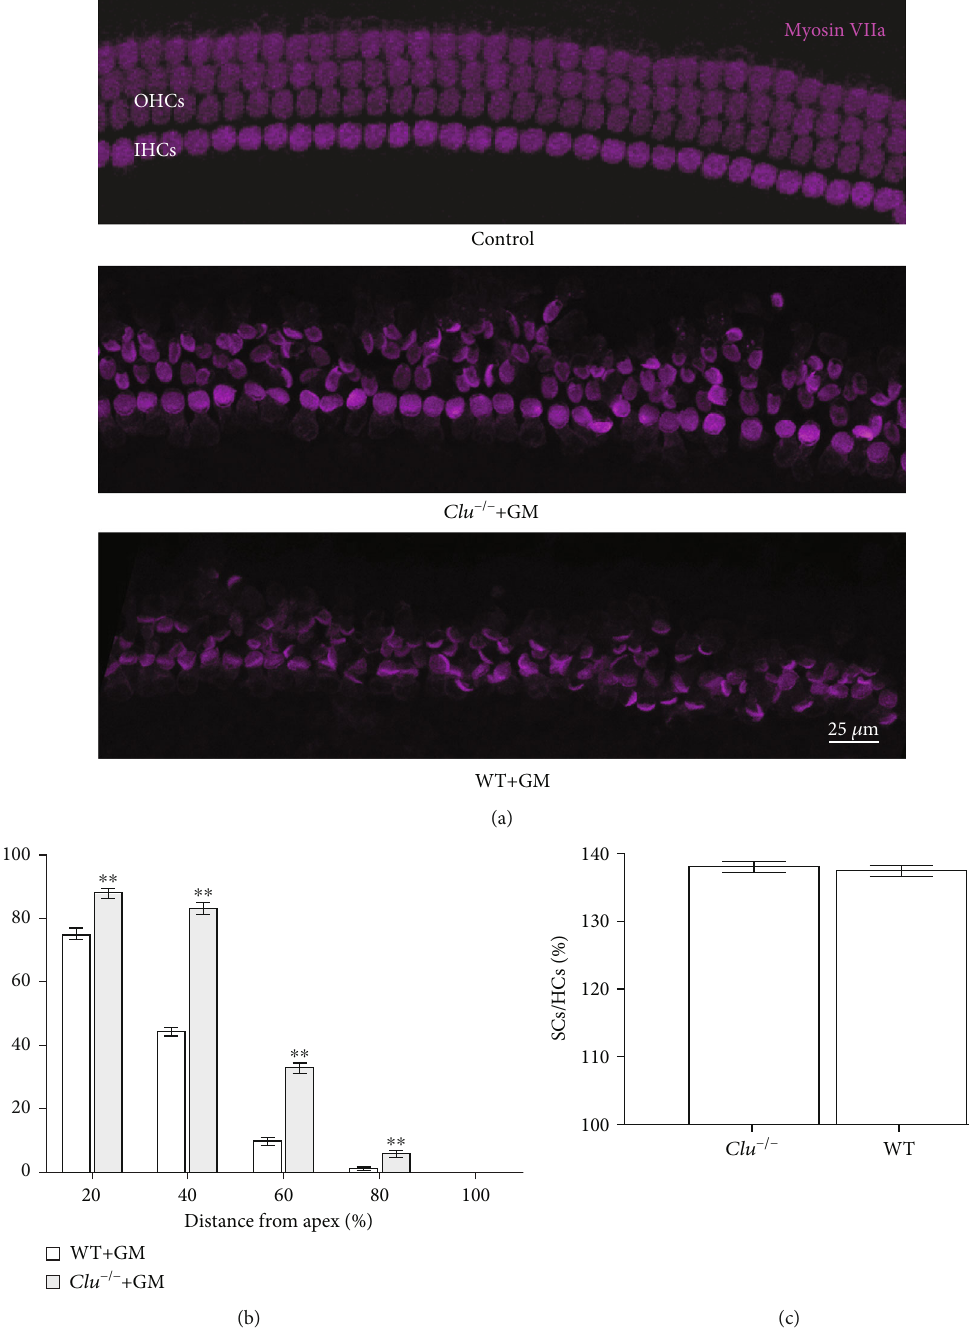
Figure 7: Clu de fi ciency attenuates gentamycin-induced cochlear hair cell death in vitro . (a) Representative images of myosin-stained hair cells in the CBM after exposure to the gentamycin (GM). n = 6 CBMS per condition. (b) Quanti fi cation of myosin staining in IHCs and OHCs. Data are presented as the mean ± SD . ∗ p < 0 : 05 , ∗∗ p < 0 : 01 . N = 6 . (c) The percentages of supporting cells and hair cells showed no signi fi cant di ff erences between WT and Clu − / − mice. N = 6